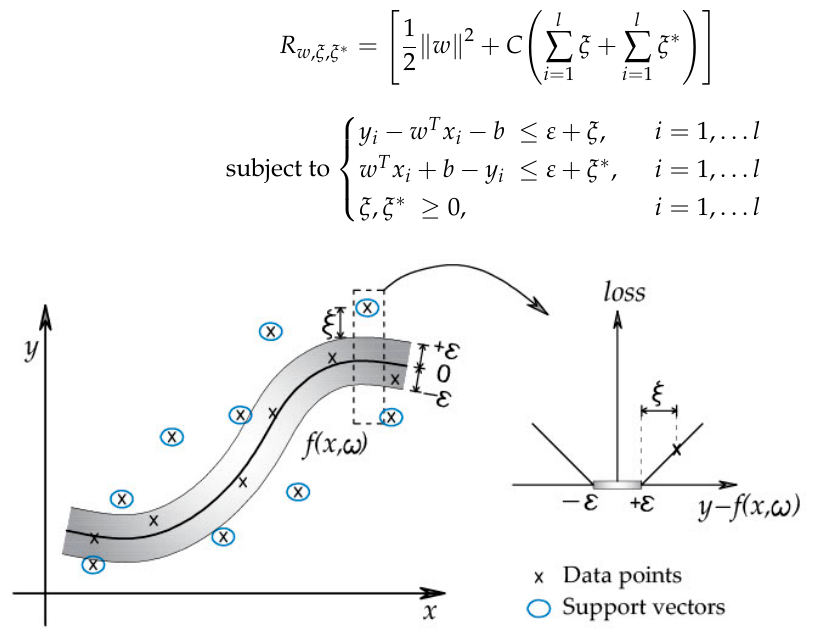
Figure 4. The soft margin loss setting for a nonlinear SVM.